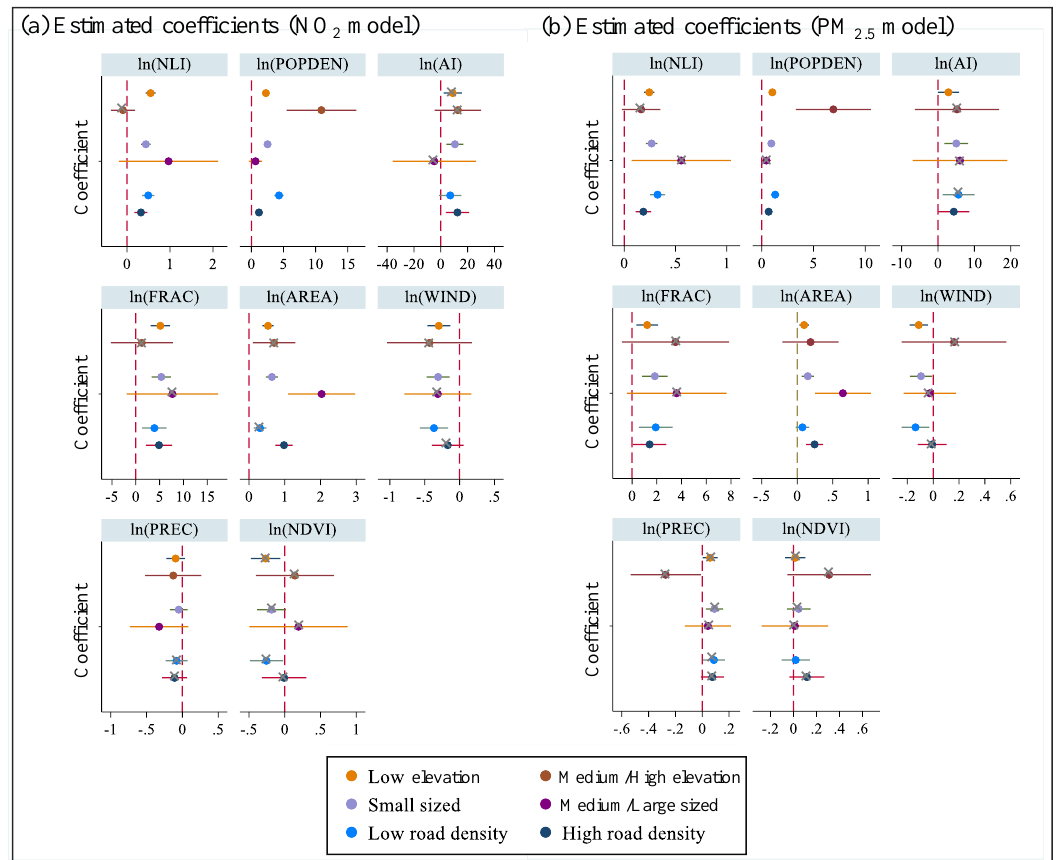
Figure 6. Estimated coe ffi cients of the FE models of cities with di ff erent sizes, elevations, and road densities. Estimated coe ffi cients in NO2 ( a ) and PM2.5 models ( b ) and Parameter bounds for the regression slope are the 95% confidence interval. Coe ffi cients with p less than 0.01 are marked with a